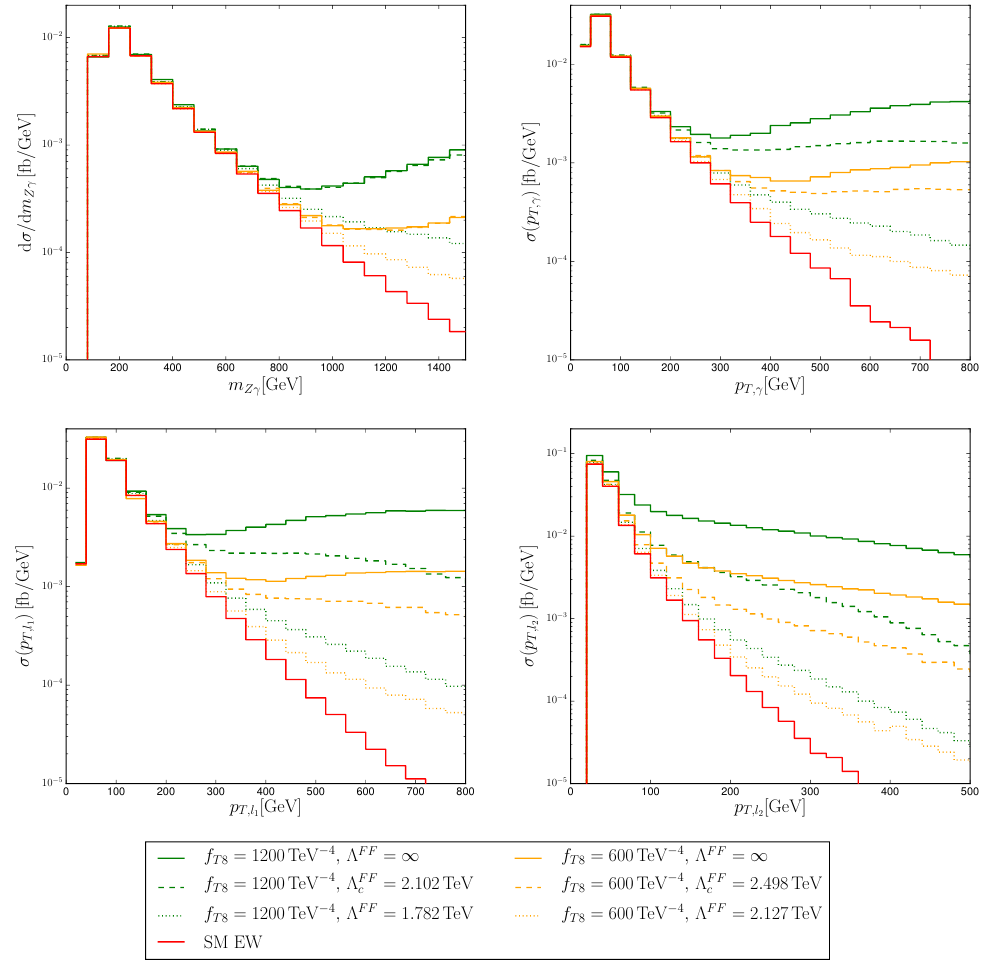
Figure 10 . Cross section of Z ‘ (cid:13)jj production in the SM and including various anomalous couplings in dependence on m Z(cid:13) and transverse momentum of the (cid:12)nal state